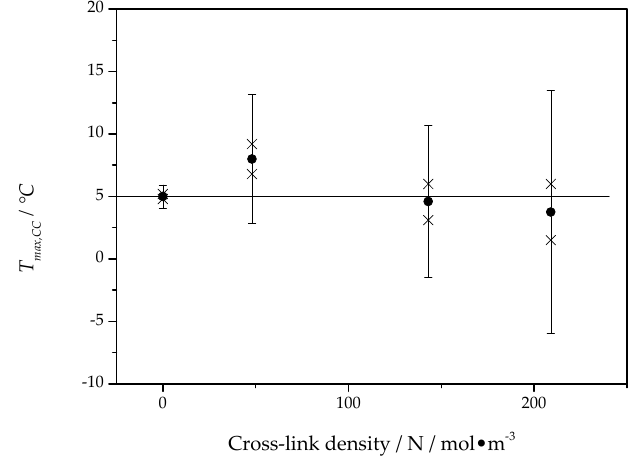
Figure 8. The asymptotic value from fits by Equation (3) to data, as shown in Figure 7, as a function of cross-link density. The horizontal line marks the mean value nearly equal to 5 ◦ C. Crosses represent the values of T lim estimated from distinct samples of PCL, solid circles represent the average value of T lim from different samples, error bars indicate the expanded uncertainty of the estimate.